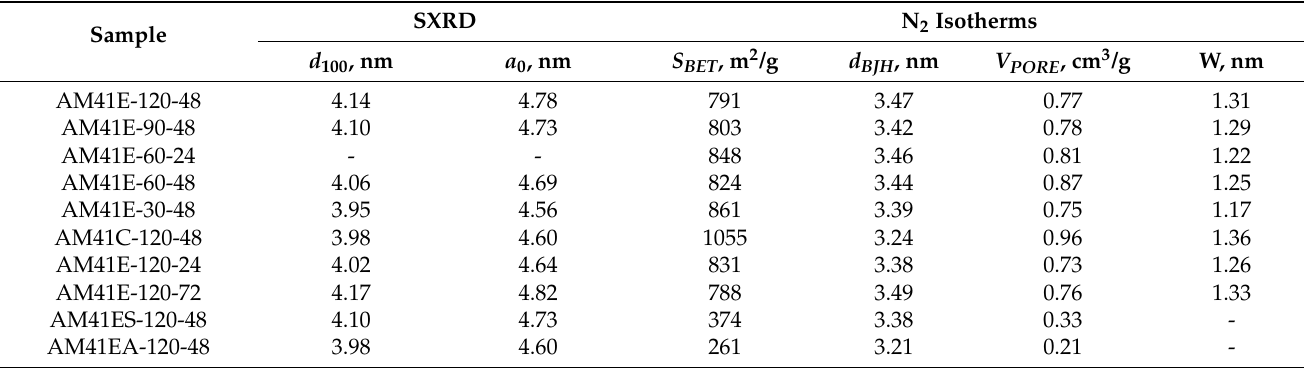
Table 5. Pore structural properties of the samples investigated in this study.